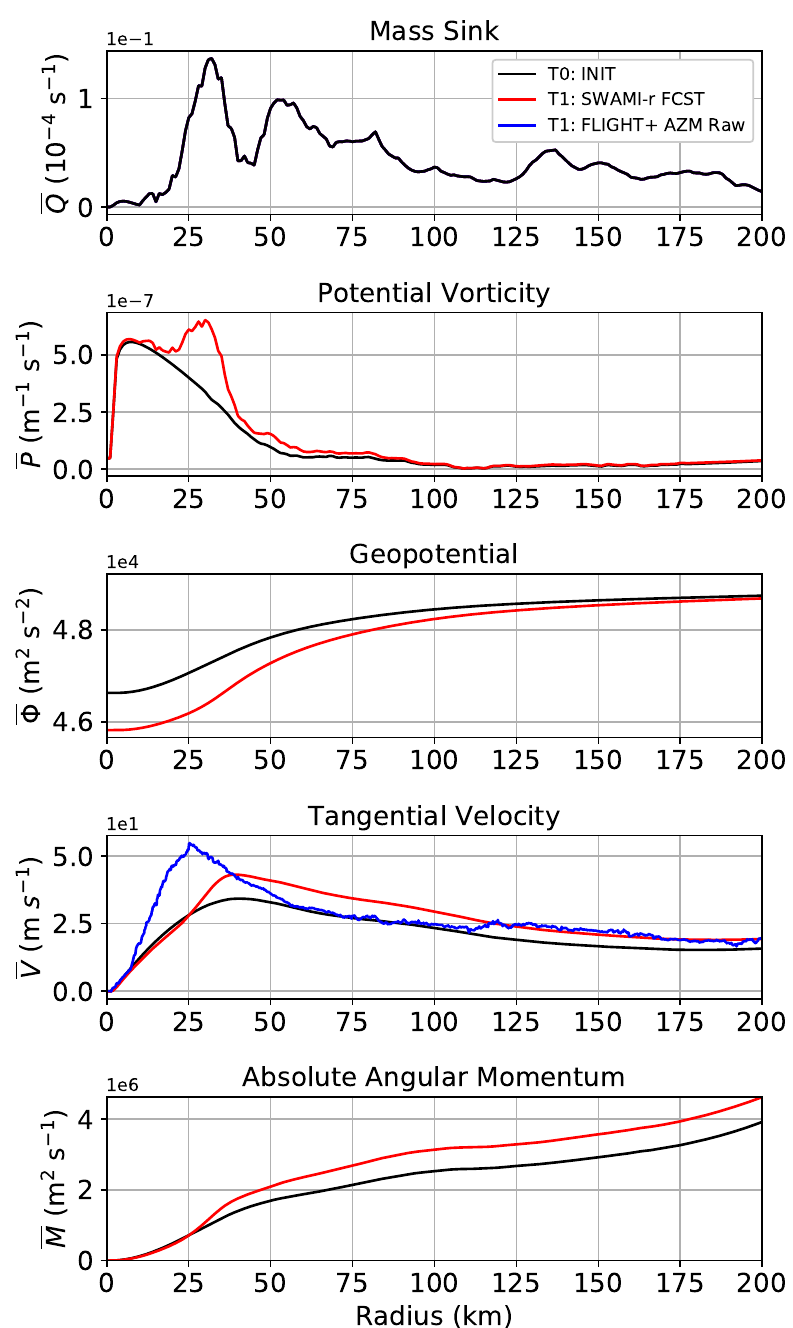
Figure 9. Rapid intensification event of Hurricane Ignacio (2015) from 29 August 2015 03:58:24 to 29 August 2015 18:21:52. The five panels show the SWAMI initialization and forecasts of PV , Φ , v , M , and the mass sink forcing Q . Verification of the SWAMI azimuthal mean tangential velocity using the 29 August 2015 18:21:52 azimuthal mean group is shown in the blue curve on the fourth